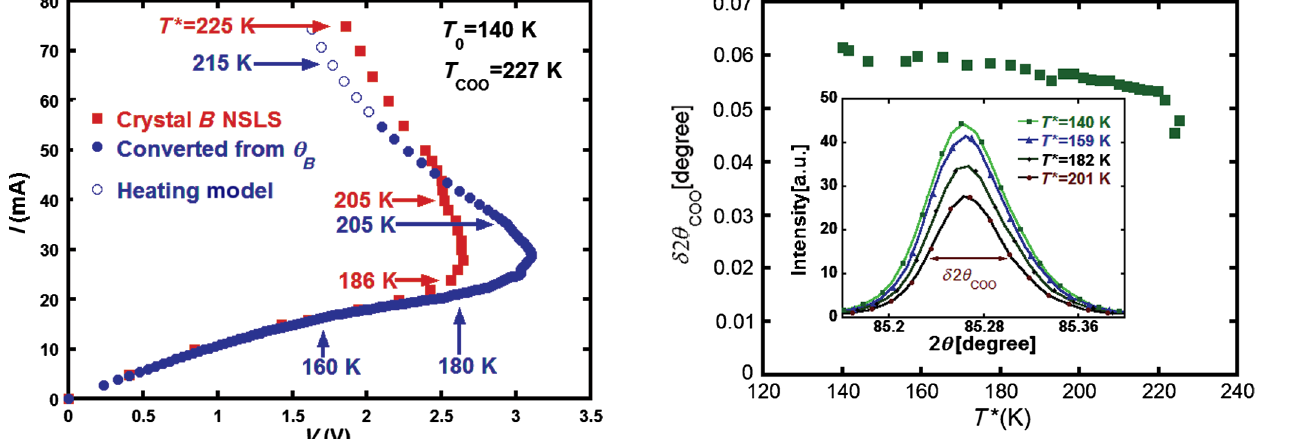
FIG. 6. The current-voltage curve I ð V Þ for crystal B (squares), measured simultaneously with the (1,1,12) Bragg peaks at the NSLS beam line X22C shown in Fig. 5(b). For each I in the above I ð V Þ , Fig. 5(b) shows the simultaneously measured 2 θ B , which uniquely determines T (cid:3) [see Fig. 5(a)]. From these data plus the thermal equilibrium transport data of Fig. 3(b), the circles represent the expectation of pure heating, and that clearly disagrees with the experimental I ð V Þ in the vertical region near 2500 mV. Note that for 230 K > T > 212 K, the 2 θ B data of Fig. 5(a) become almost independent of T and thus are not useful as a thermometer. Although this range is not necessary for the conclusions of this paper, we use the measured power IV and a simple heating model to determine the six highest-current, unfilled circles.